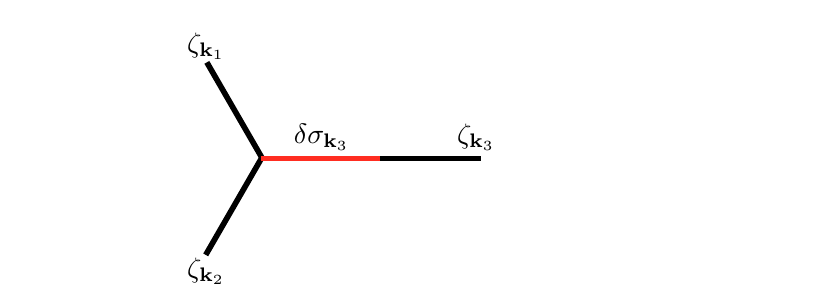
Figure 6 . We set k = 1 and (cid:20) = 0 ; (cid:0) i; (cid:0) 2 i; (cid:0) 3 i; (cid:0) 4 i; (cid:0) 5 i; (cid:0) 6 i respectively. For small electric z =k (cid:12)eld strength, the power spectrum decreases following the power 1 = j (cid:22) j 2 , whereas when the electric (cid:12)eld strength increases, the power spectrum decays exponentially when the mass increases.